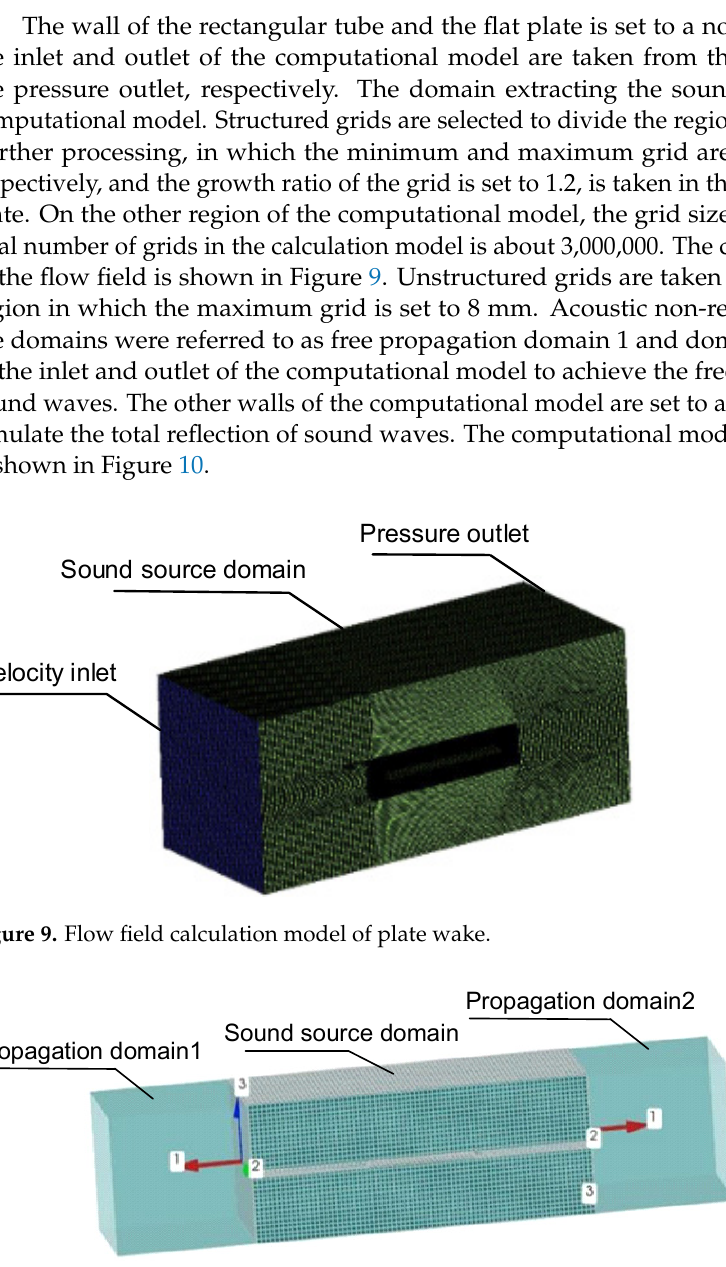
Figure 10. Sound field calculation model of plate wake.